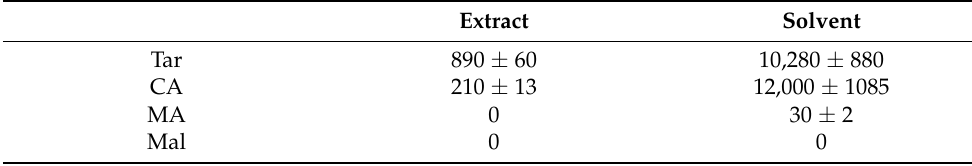
Table 6. The number of Escherichia coli bacterial cells in solution (c/mL) when extracts and solvents at a concentration of 5% (initial number, 65,000 ± 5430 c/mL) are